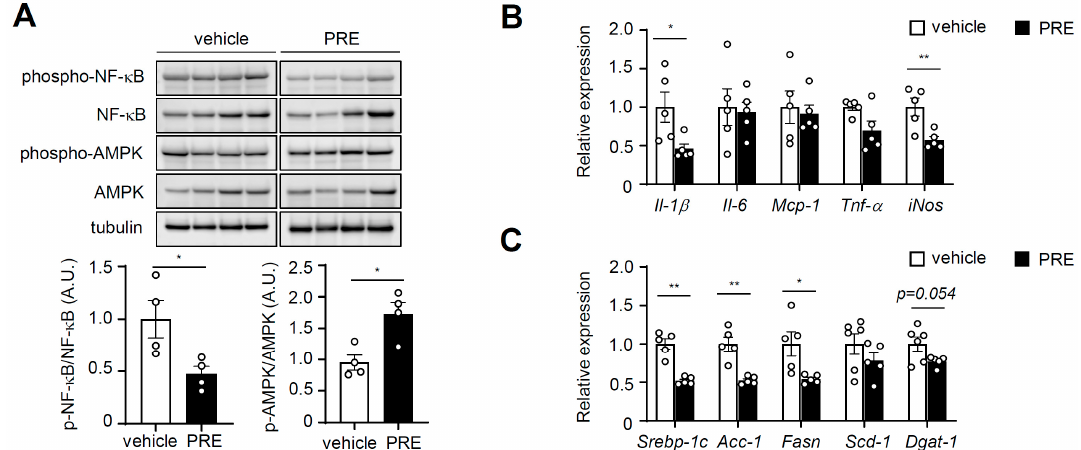
Figure 4. PRE ameliorated adipose tissue inflammation. Adipose tissue was isolated from DIO mice in the non-fasted state. ( A ) The extracts were analyzed with phospho-NF- κ B, NF- κ B, phospho-AMPK, AMPK, and tubulin by Western blot. A.U., arbitrary units. Data are shown as the mean ± S.E.M. ( n = 4) * p < 0.05; ** p < 0.001; *** p < 0.0001 vs. HFD-fed vehicle group. The mRNA levels of pro-inflammatory genes ( B ) and lipogenic genes ( C ) were analyzed by quantitative real-time PCR. Data are shown as the mean ± S.E.M. ( n = 5) * p < 0.05; ** p < 0.001; *** p < 0.0001 vs. HFD-fed vehicle group.